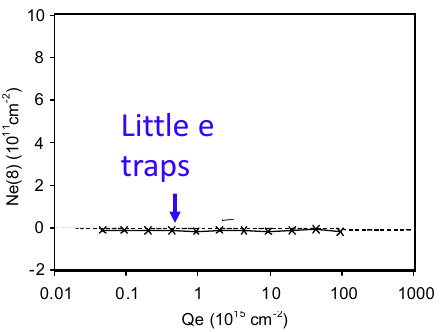
Figure 36. There are little as-grown electron traps in the poly-Si-gated SiO 2 [62]. When the high-k/SiON stack is used, PBTI becomes considerable. In the early stage of high-k process development, PBTI was so severe that it limited the commercial use of the process as detailed in the next section.